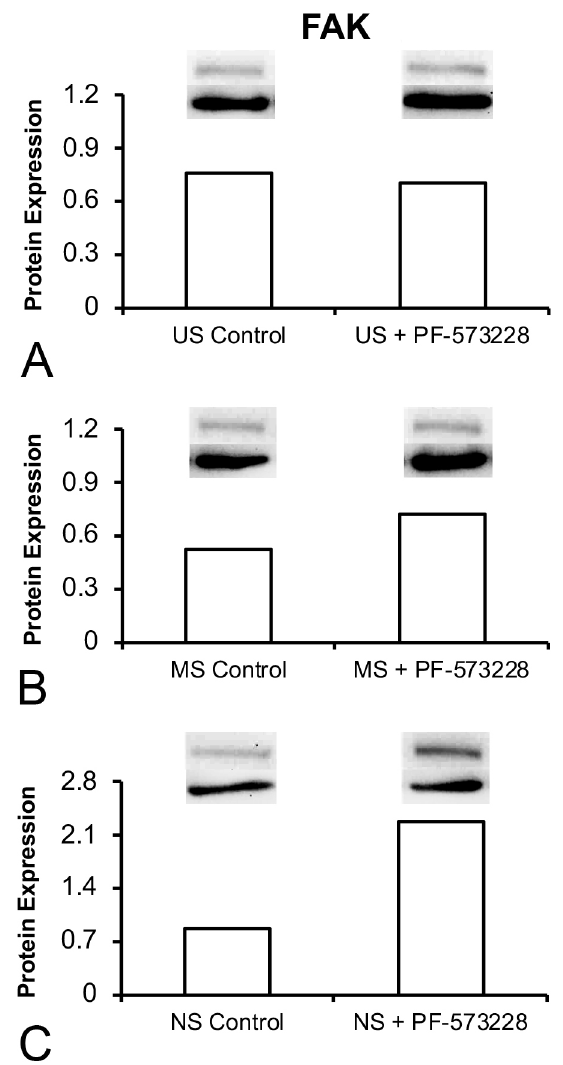
Figure 8- Protein expression of focal adhesion kinase (FAK) in cells cultured on US (A), MS (B), and NS (C) in the presence or absence of 0.1 µM PF-573228 on day